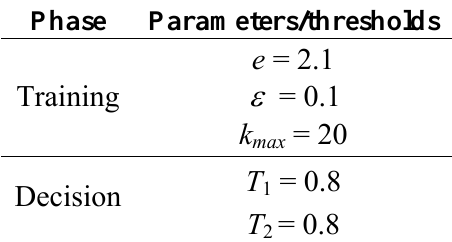
Table 3. Parameters and thresholds involved in the process of pixel-based